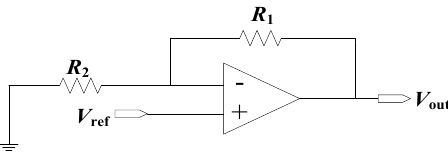
Figure 2. Constant current circuit for the microhotplate.